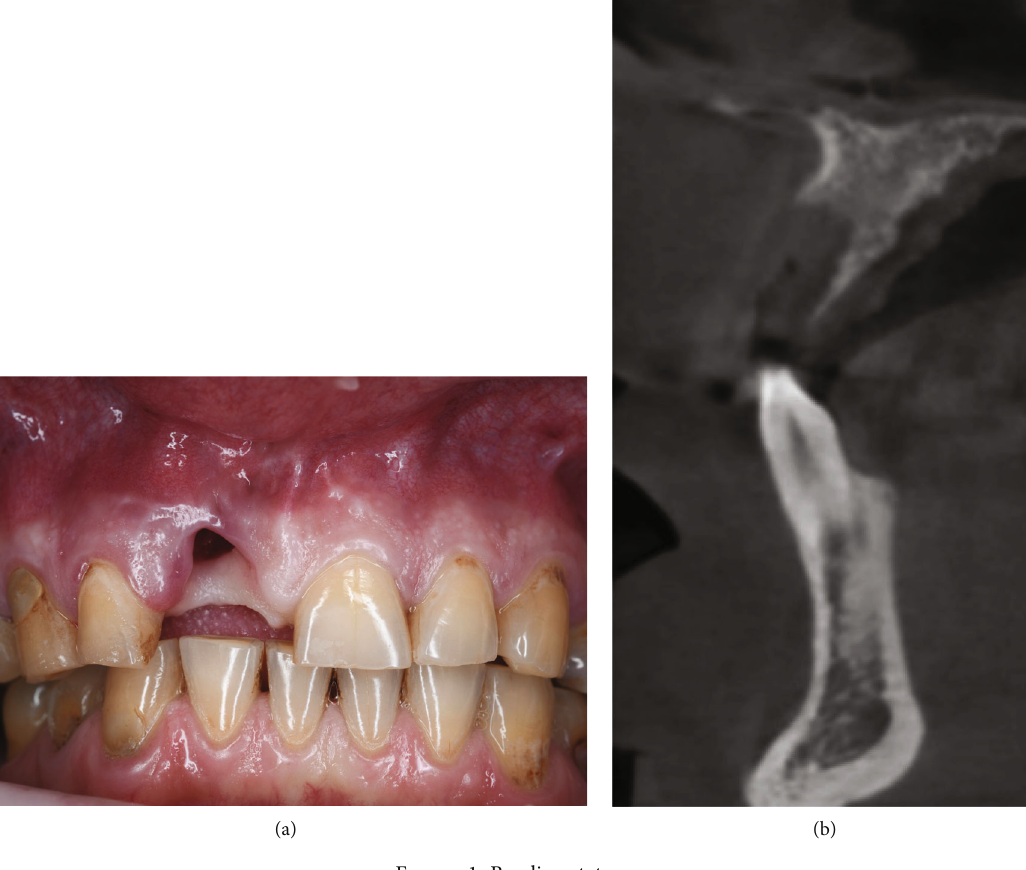
Figure 1: Baseline